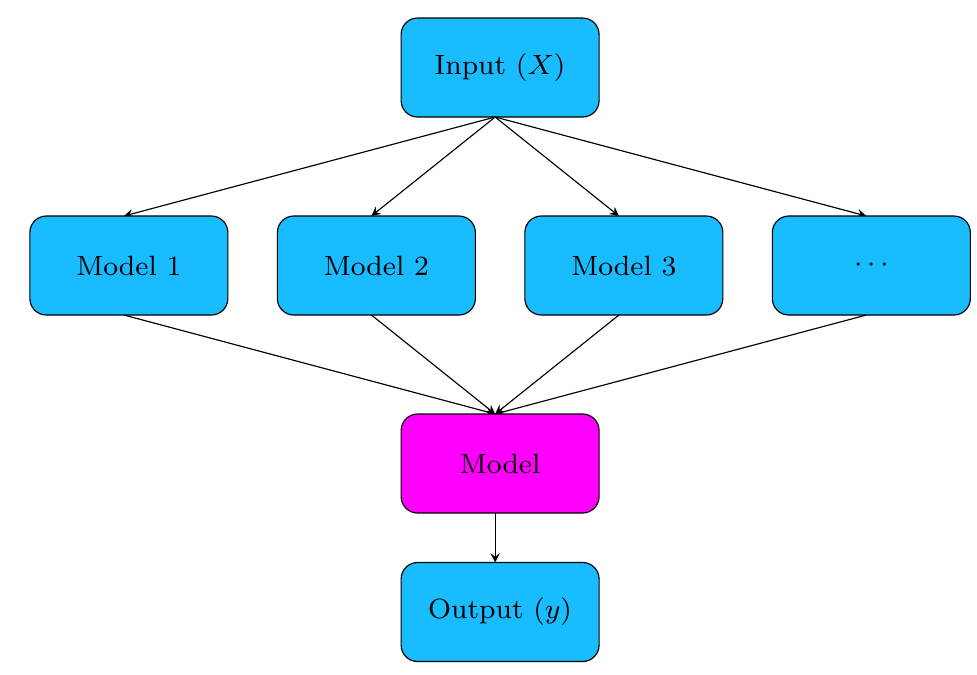
Figure 8. Schematic view of stacking